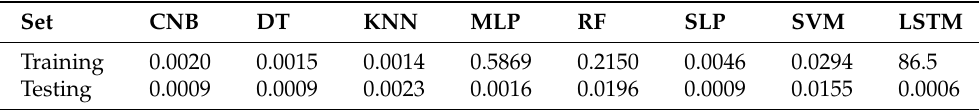
Table 4. Execution time of different models (in